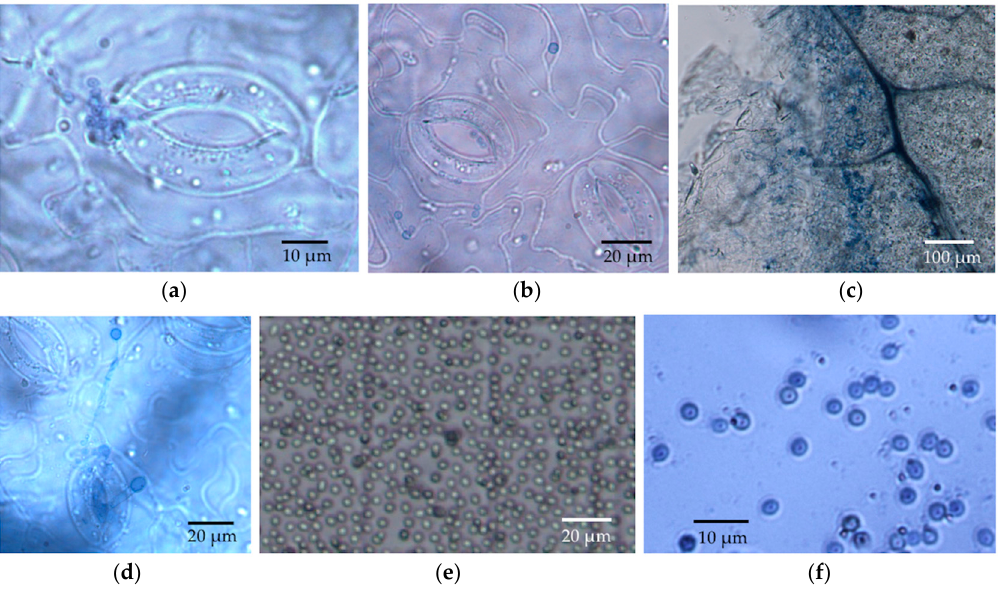
Figure 8. LM photos of in vitro inoculation with Trichoderma sp. NM2012. ( a ) Non-germinated conidia, 7 DAI; ( b ) Non-germinated conidia, 14 DAI; ( c ) Hyphal growth at the margin of leaf disc, 3 DAI; ( d ) Chlamydospores, 3 DAI; ( e ) Conidia from fresh cultures on hemocytometer; ( f ) Chlamydospores from a four-month culture.